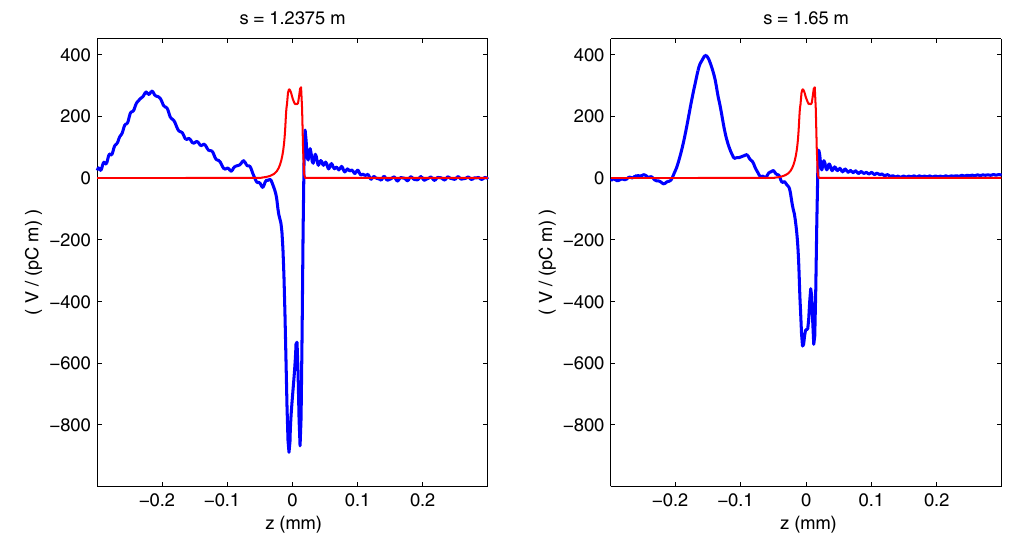
FIG. 21. Wakefield W ð z; s Þ as a function of z ¼ s − β ct at s ¼ 1 . 2375 m (left) and at s ¼ 1 . 65 m (right).